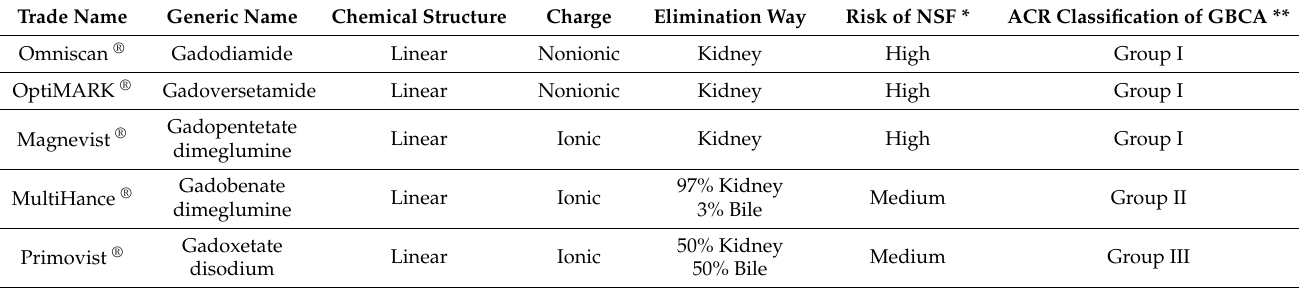
Table 1. Characteristics of contrast